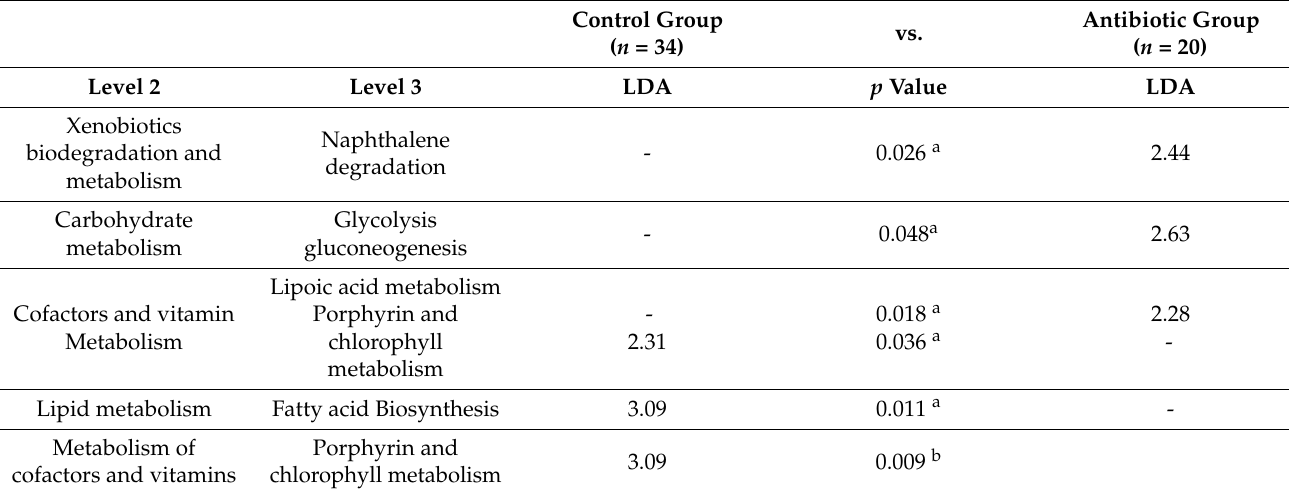
Table 2. Kyoto Encyclopedia of Genes and Genomes functional profiling. Control